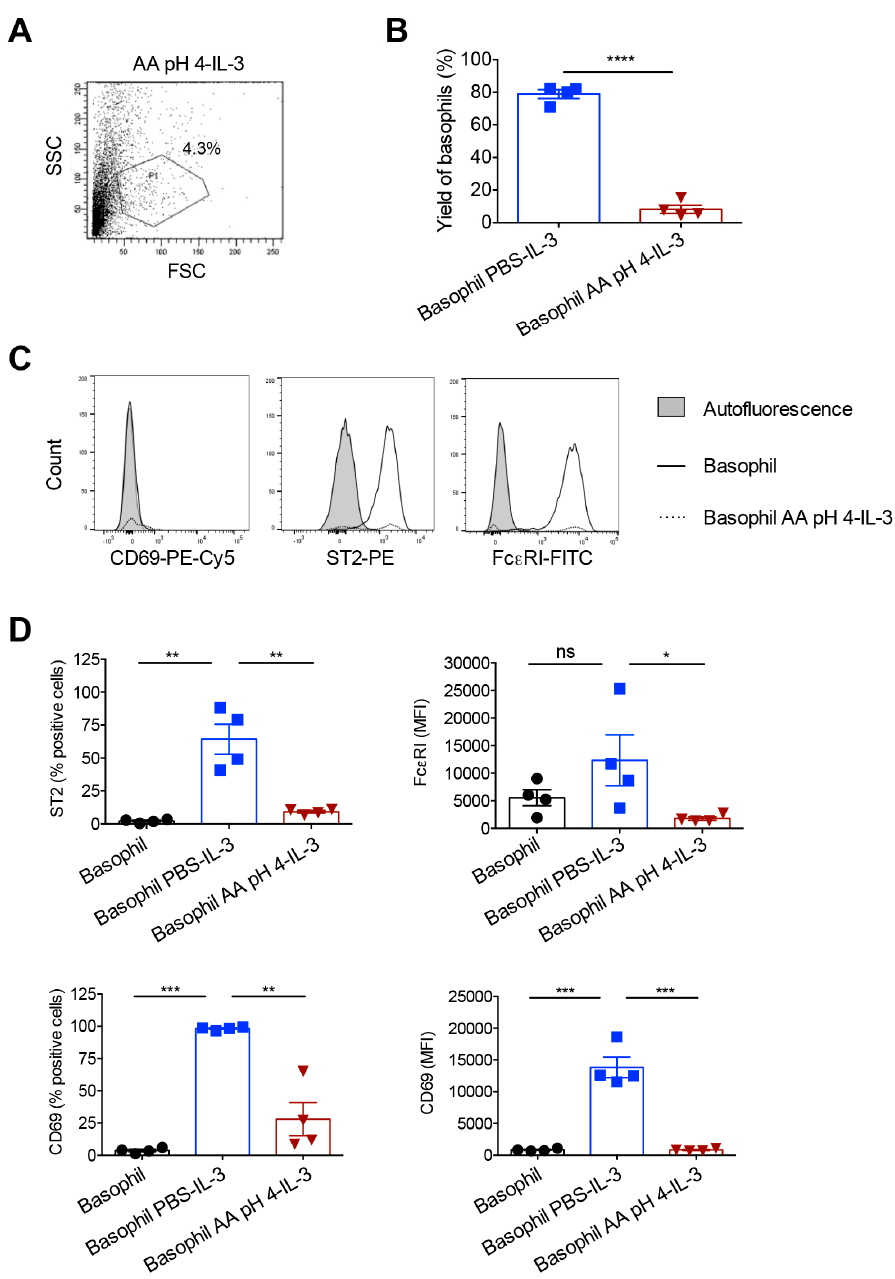
Figure 4. Response of the acetic acid bu ff er (pH 4)-treated human basophils to IL-3 stimulation. Basophils were incubated on ice for 5 min either with phosphate bu ff ered saline (PBS) or ice-cold acetic acid bu ff er pH 4 (AA pH 4). Cells were then washed and cultured in serum-free X-VIVO 15 medium (0.1 × 10 6 cells / well per 200 µ L) in 96-well U-bottomed plate along with IL-3 (100 ng / 0.5 million cells) for 24 h. ( A ) The forward and side scatter plot of AA pH 4-treated basophils following 24-h culture in IL-3. ( B ) The yield of basophils (mean ± SD, n = 4 donors) after 24 h culture of basophils in IL-3. The values were calculated based on the percentage of cells in the P1 gate of forward and side scatter plot. ( C ) Histogram overlays showing the expression of basophil activation markers CD69, ST2 and Fc ε RI in AA pH 4-treated cells after 24 h culture in IL-3. Representative data from four donors are presented. ( D ) The expression (mean ± SD, n = 4 donors) of various activation markers (% positive cells or median fluorescence intensity, MFI) after 24 h culture of basophils in IL-3. * p < 0.05; ** p < 0.01; *** p < 0.001; **** p < 0.0001; ns, not significant; two-sided Students t-test (panel B) or one-way ANOVA with Tukey’s multiple comparison test (panel D).